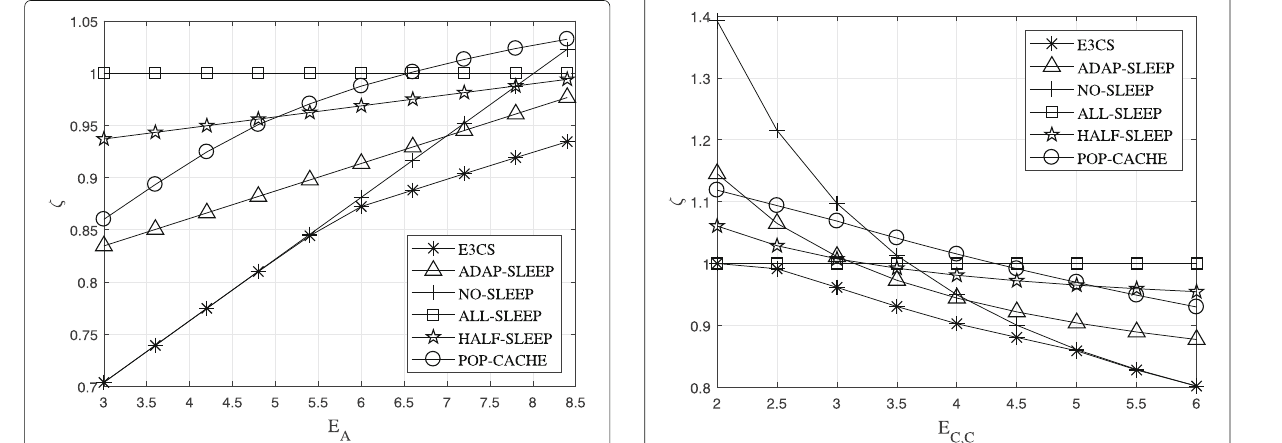
Fig. 4 Effect of the energy consumption E C , C to retrieve contents from the remote content